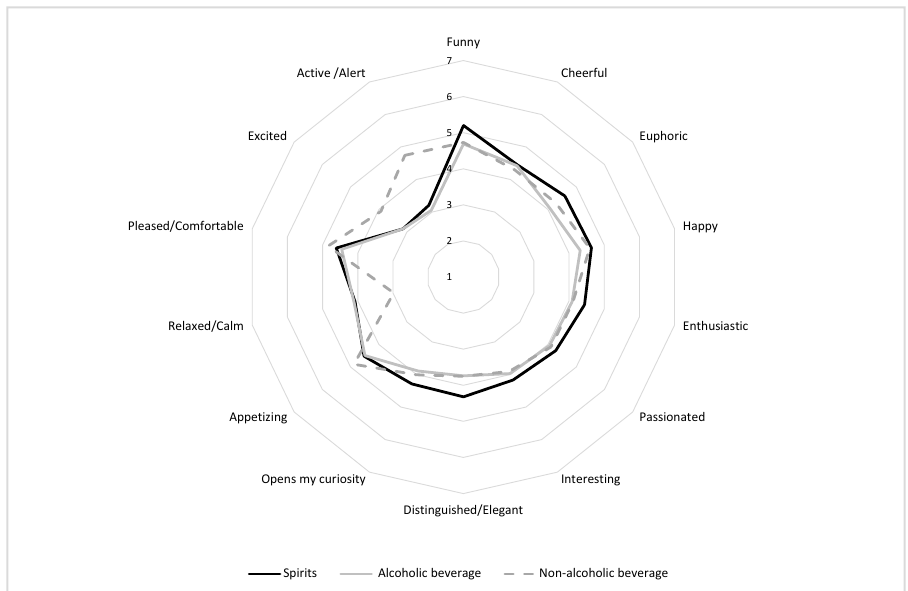
Figure 1. Positive emotional associations with beverage products.